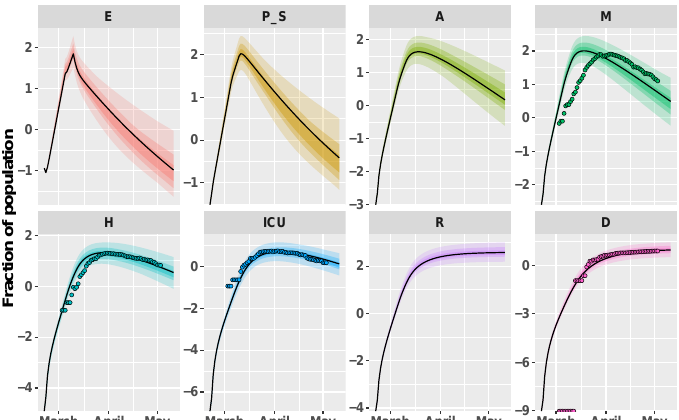
Figure 3. Umbria example. Time behavior of state variables when the parameter vector is equal to the final mode vector that is computed by CRC (black line); dots represent the data available at [21]. Data and simulations are in log-scale, normalized over the whole population of the region ( ∼ 882,000) and multiplied by 10 5 . The colored area reproduces the variation of the temporal behavior when parameters vary between the 60th, 70th, and 90th percentile of their corresponding conditional pdfs (see Supplementary Materials). Time starts from 21 February 2020.